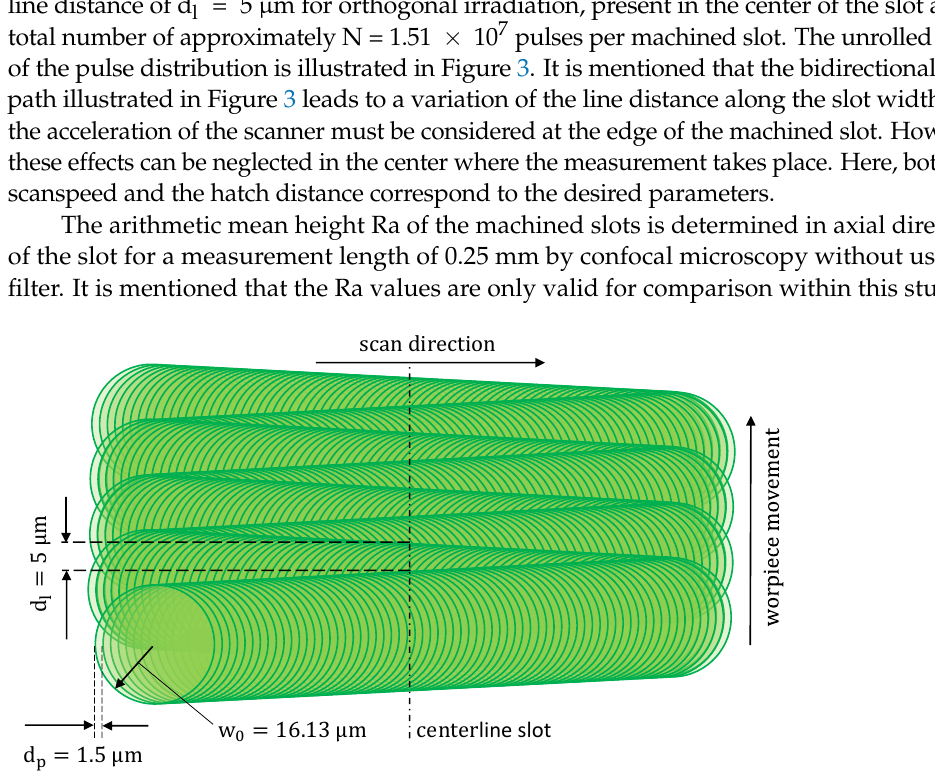
Figure 3. Illustration of the unrolled pulse distribution on the workpiece for the calibration experi- ment with the parameters listed in Table 1 at orthogonal